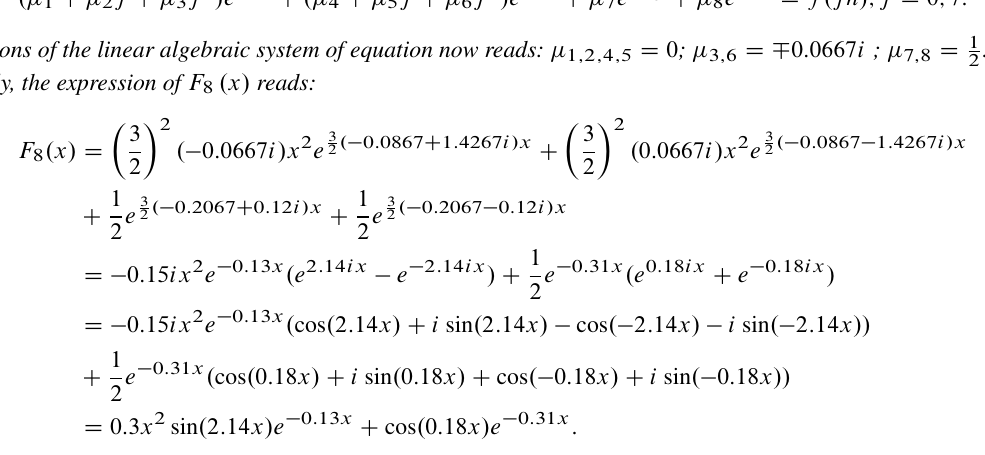
, then the characteristic polynomial 3